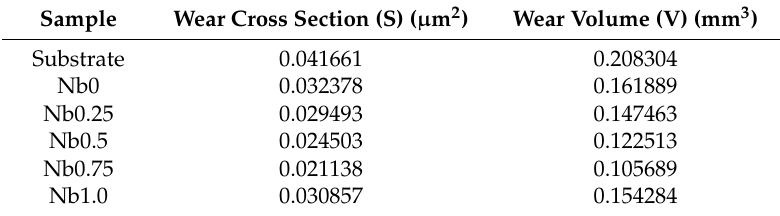
Table 4. Wear data of the substrate and the AlCoCrFeNiNb x high-entropy alloy coatings. Wear Cross Section Sample